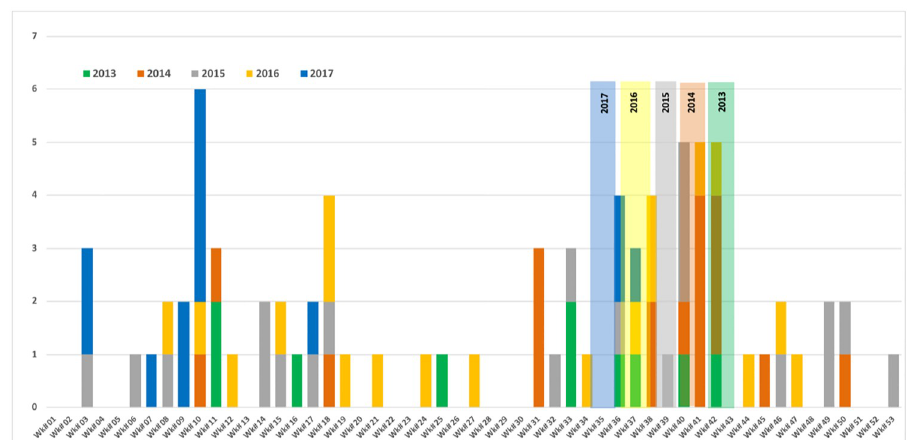
Fig 3. Weekly distribution of CCHF cases in Oman showing clustering after Eid Al Adha: 2013–2017 (n = 80). Eid Al Adha occurs 10 days earlier in each successive year, indicated by the pale vertical columns between weeks 35 and 43. The risk period is defined as approximately 10 days after the Eid Al Adha festival.